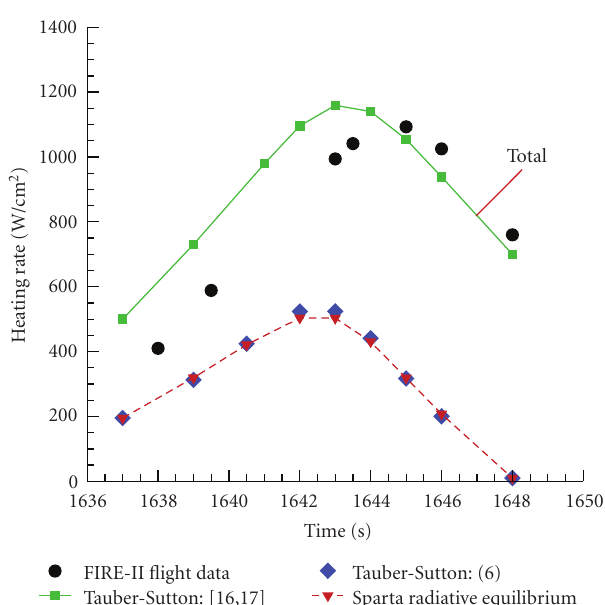
Figure 17: Radiative stagnation point heating of FIRE II data at a re-entry velocity of 11.37